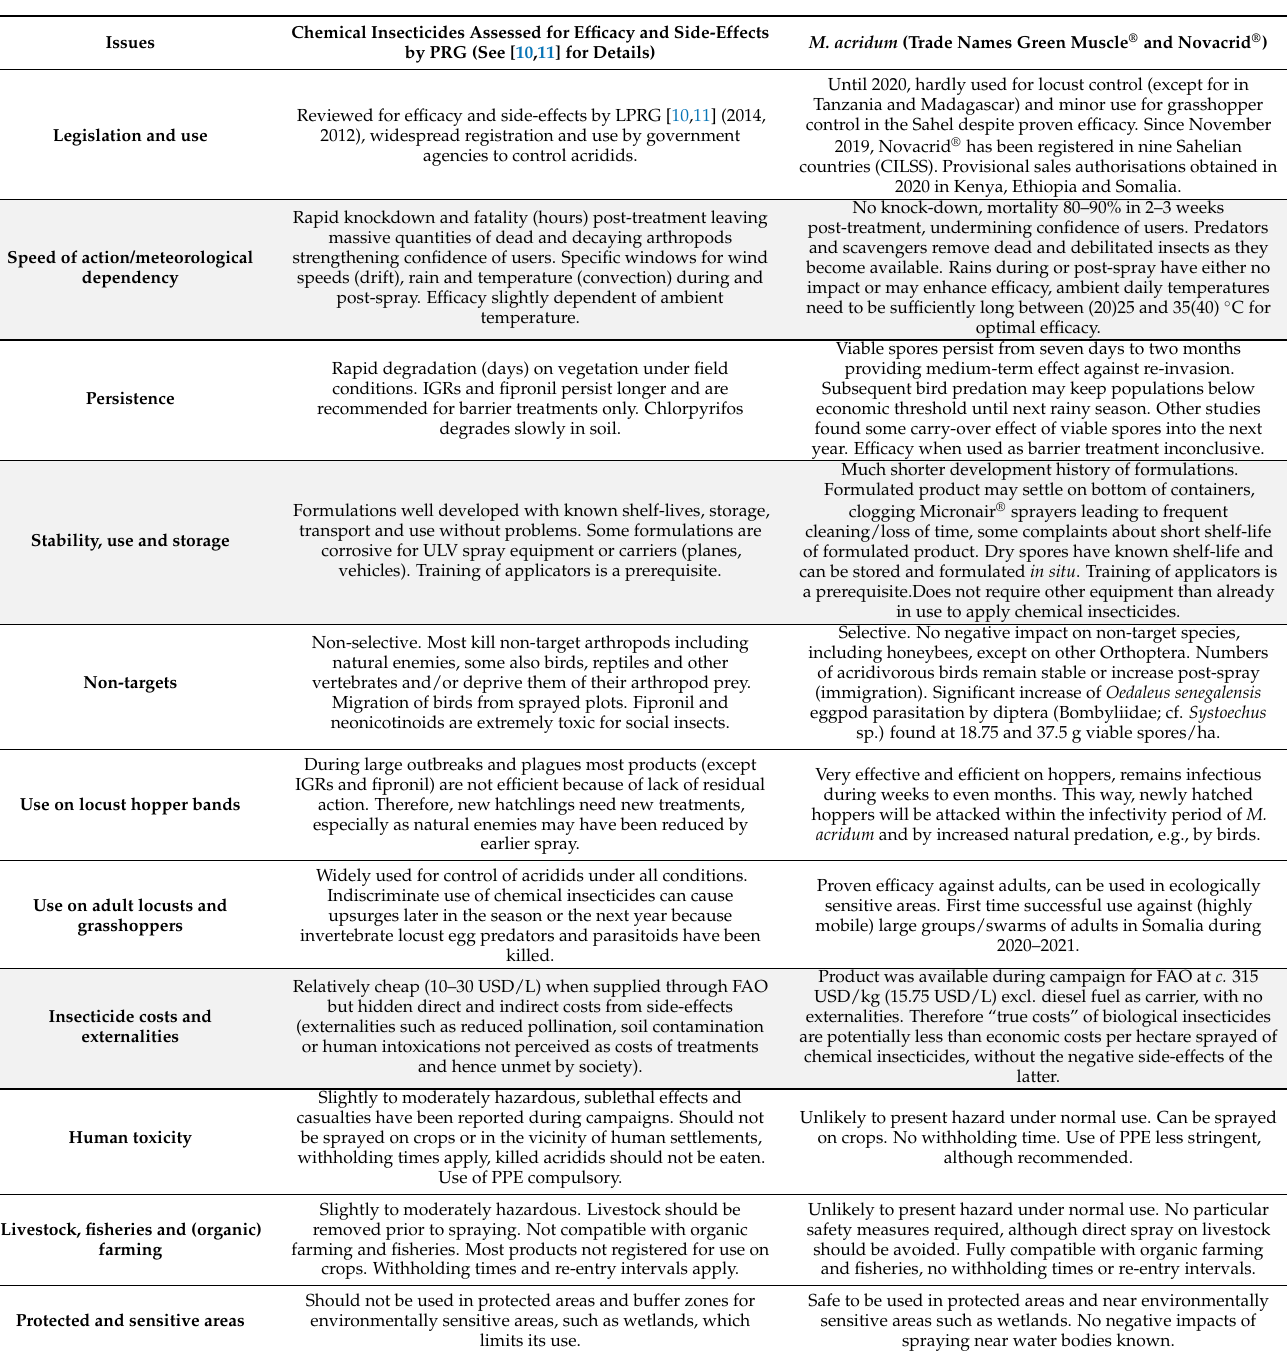
Table 3. Specific traits of chemical insecticides and M. acridum in acridid control. Arguments highlighted in shaded cells are frequently used to justify the use of chemical insecticides. (Adapted from Mulli é